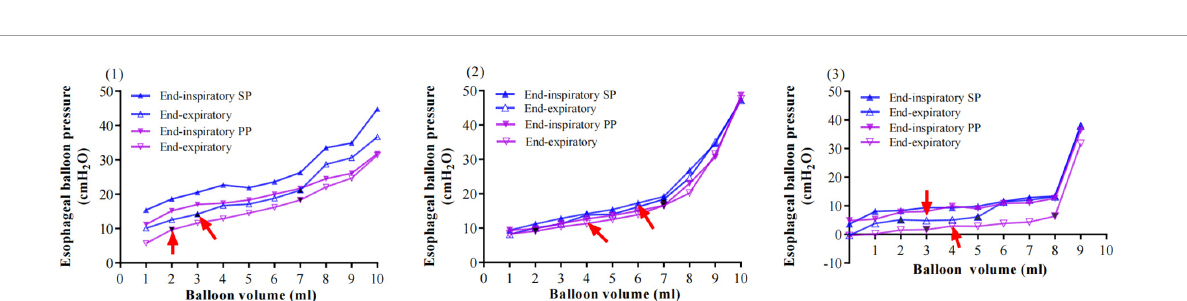
FIGURE6 Examples of inspiratory and expiratory esophageal balloon pressure-volume curves in different positions. Three patients’ relationships between balloon filling volume and values of Pes in the supine position (Pes EI , solid blue triangle; Pes EE , hollow blue triangle) and the prone position (Pes EI , solid purple triangle; Pes EE , hollow purple triangle). The red arrow represents the V BEST , while the solid black triangle represents V MIN and V MAX . Patients in the prone position had lower Pes than those in the supine position. (1) An 18-years-old female patient, BMI 23.4 kg/m 2 , with infective endocarditis (IE), severe pneumonia (methicillin-resistant staphylococcus aureus, MRSA), post-operative mitral valve replacement, and pulmonary ARDS with diffuse lesion. PC 13 cm H 2 O, PEEP 8 cm H 2 O; V MIN 3 vs. 2 ml, V MAX 6 vs. 6 ml and V BEST 3 vs. 2 ml. (2) A 74-years-old male patient, BMI 24.8 kg/m 2 , with severe pneumonia, septic shock and pulmonary ARDS with diffuse lesions. PC 9 cm H 2 O, PEEP 9 cm H 2 O; V MIN 2 vs. 2 ml, V MAX 7 vs. 7 ml and V BEST 6 vs. 4 ml. (3) A 74-years-old male patient, BMI 22.9 kg/m 2 , with severe pneumonia, and pulmonary ARDS with diffuse lesions. PC 12 cm H 2 O, PEEP 6 cm H 2 O; V MIN 2 vs. 3 ml, V MAX 8 vs. 8 ml and V BEST 3 vs. 4